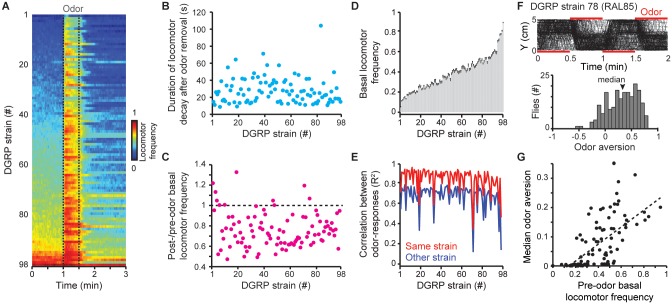
Locomotor patterns for genetically distinct Drosophila strains.(A) Locomotor frequency for 98 strains from the Drosophila melanogaster Genetic Reference Panel (DGRP) during the odor impulse experiment. Strains are sorted by average pre-odor basal locomotor frequency. (B) The duration of locomotor decay following odor removal for all DGRP strains. Strains are ordered as in panel A. (C) The ratio of post-odor to pre-odor basal locomotion for all DGRP strains. Strains are ordered as in panel A. The black dashed line indicates no change in basal locomotion. Values below this line represent reduced post-odor basal locomotor frequency. (D) The basal locomotor frequency for 65 randomly sampled flies (50% of flies for the strain with the smallest sample size: 130 flies) from each strain. The mean (light gray boxes) and standard deviation (black error bars) of 100 random samplings for each strain are shown. Strains are ordered as in panel A. (E) The correlation (R2) between odor-evoked locomotion time-series for groups of 65 randomly sampled flies taken from either the same strain (red) or from different Drosophila strains (blue). Strains are ordered as in panel A. The mean of 100 correlation measurements is shown. (F) Walking trajectories (black lines) along the long axis of the arena during an odor aversion experiment for 201 flies of the DGRP strain 78 (RAL85). Red bars indicate the half of the arena filled with odor. A histogram of odor aversion values for these flies is shown below. For each fly, odor aversion was calculated as the time spent in the odor zone subtracted from the time spent in air zone, divided by the total time of the odor aversion experiment. The median for this population of flies is indicated (black arrowhead). (G) A scatter plot showing the correlation between mean pre-odor basal locomotion and median odor aversion across all 98 strains (Pearson’s correlation coefficient R = 0.65, P < 10−4). A black dashed line indicates the best linear fit.